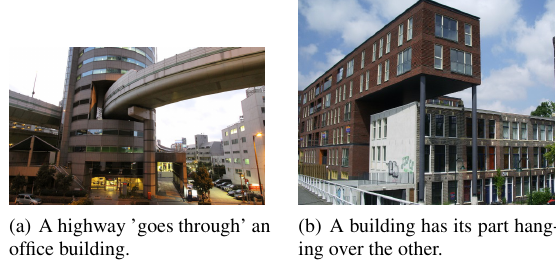
Figure 1: Real world situations that are difficult to model only by 2D